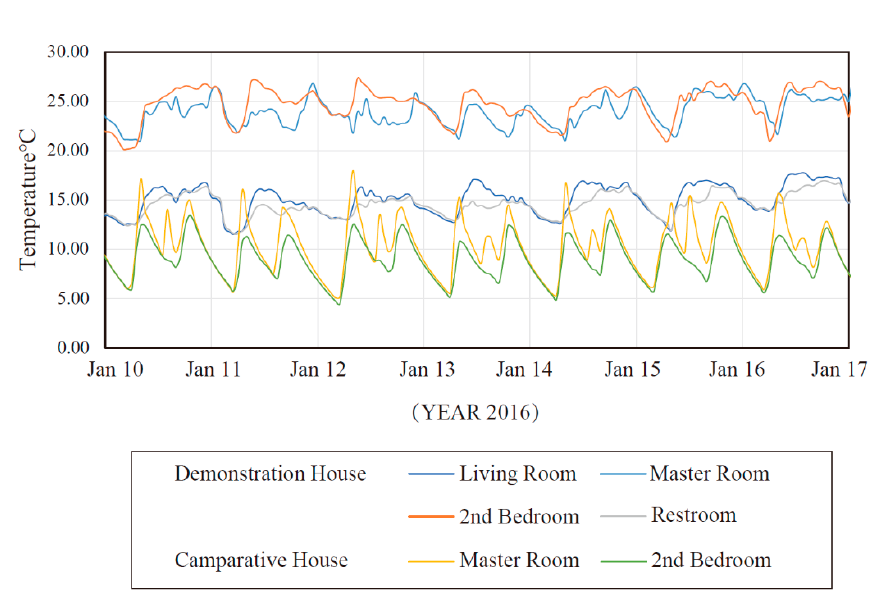
Figure 18. Temperature of the main room.